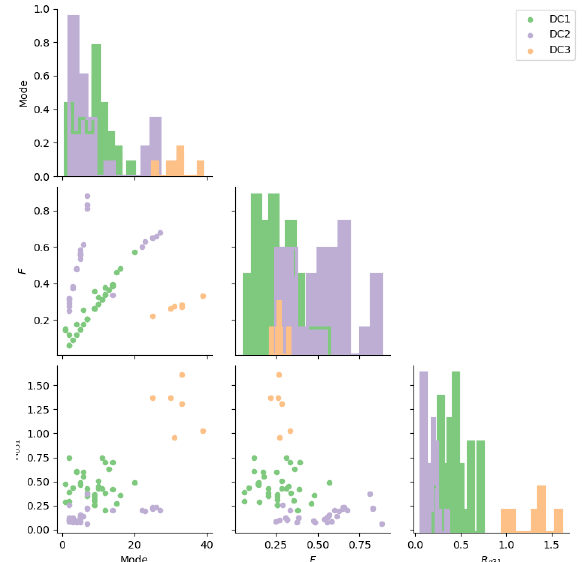
Figure 7. The resulting three clusters from the Gaussian mixture algorithm in the same parameter space as for Figure 6. The clusters are assumed to be overlapping and non-symmetric Gaussians in the parameter space. The distributions of the individual model tests among the clusters are given in Table